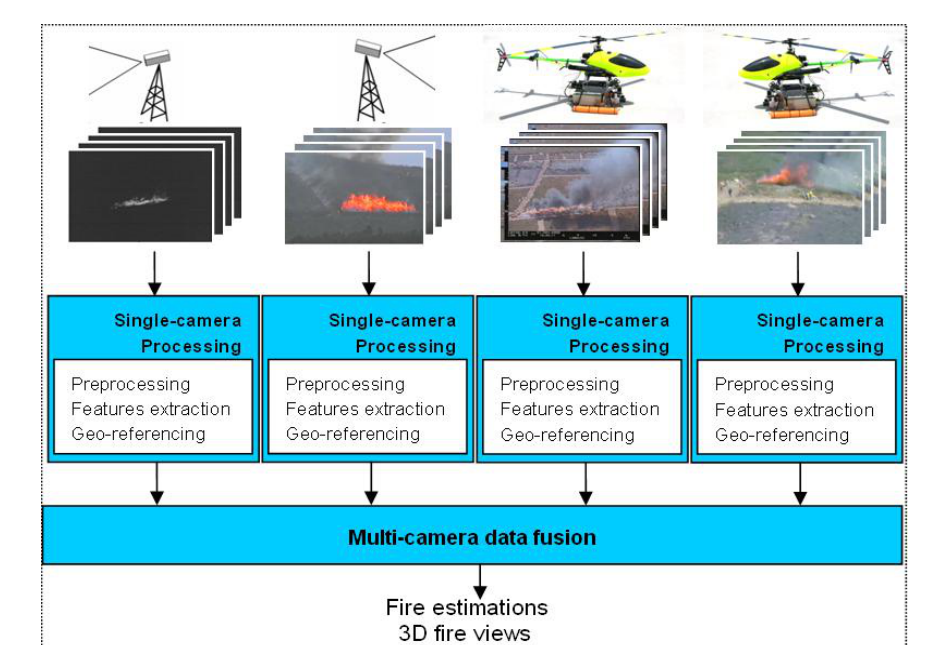
Figure 4. Diagram of the proposed forest-fire measurement